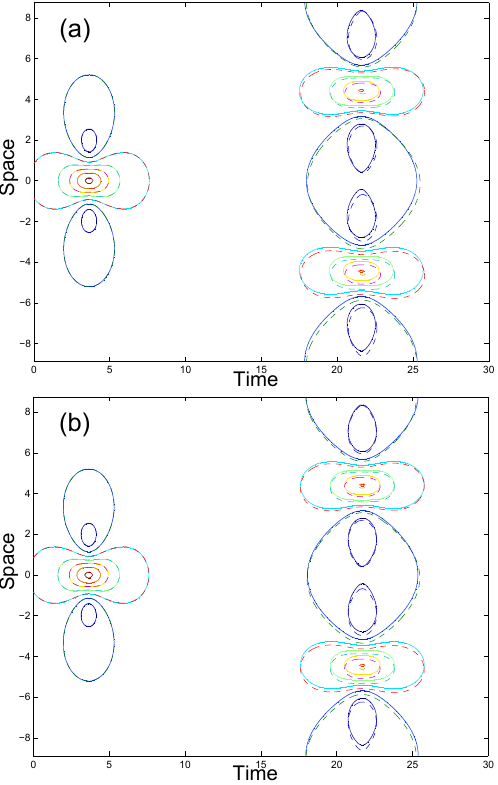
Figure 8. Contours of | U (cid:15) (x,t) | for f 4 (x) (dashed line) and the two-mode SPB (solid line) given by (a) | U ( 1 , 2 ) (x,t ; ρ ∗ ,τ 0 ) | and